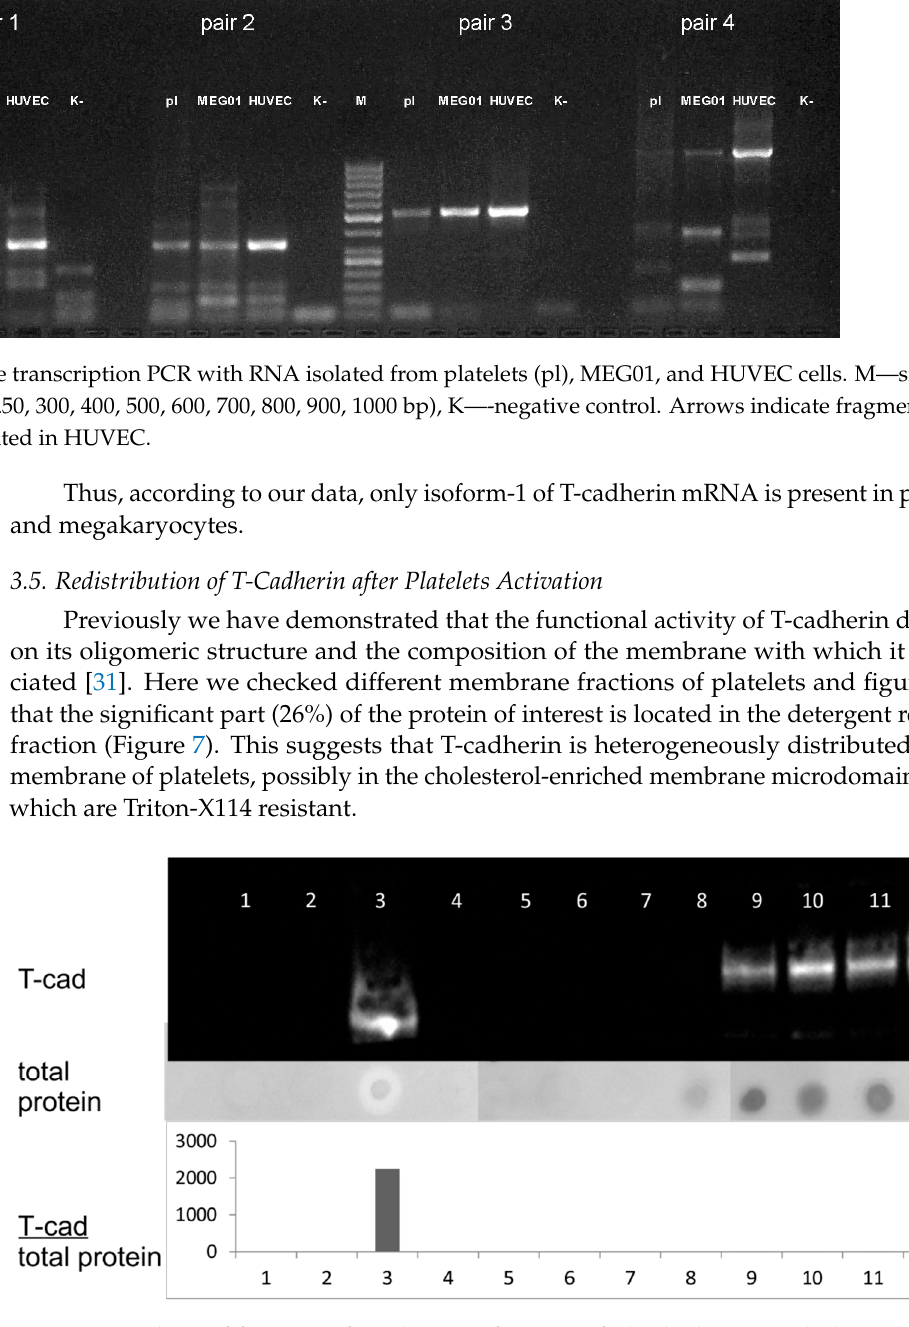
detergent. 1–12—the fractions obtained after ultracentrifugation. Upper panel—immunoblotting of